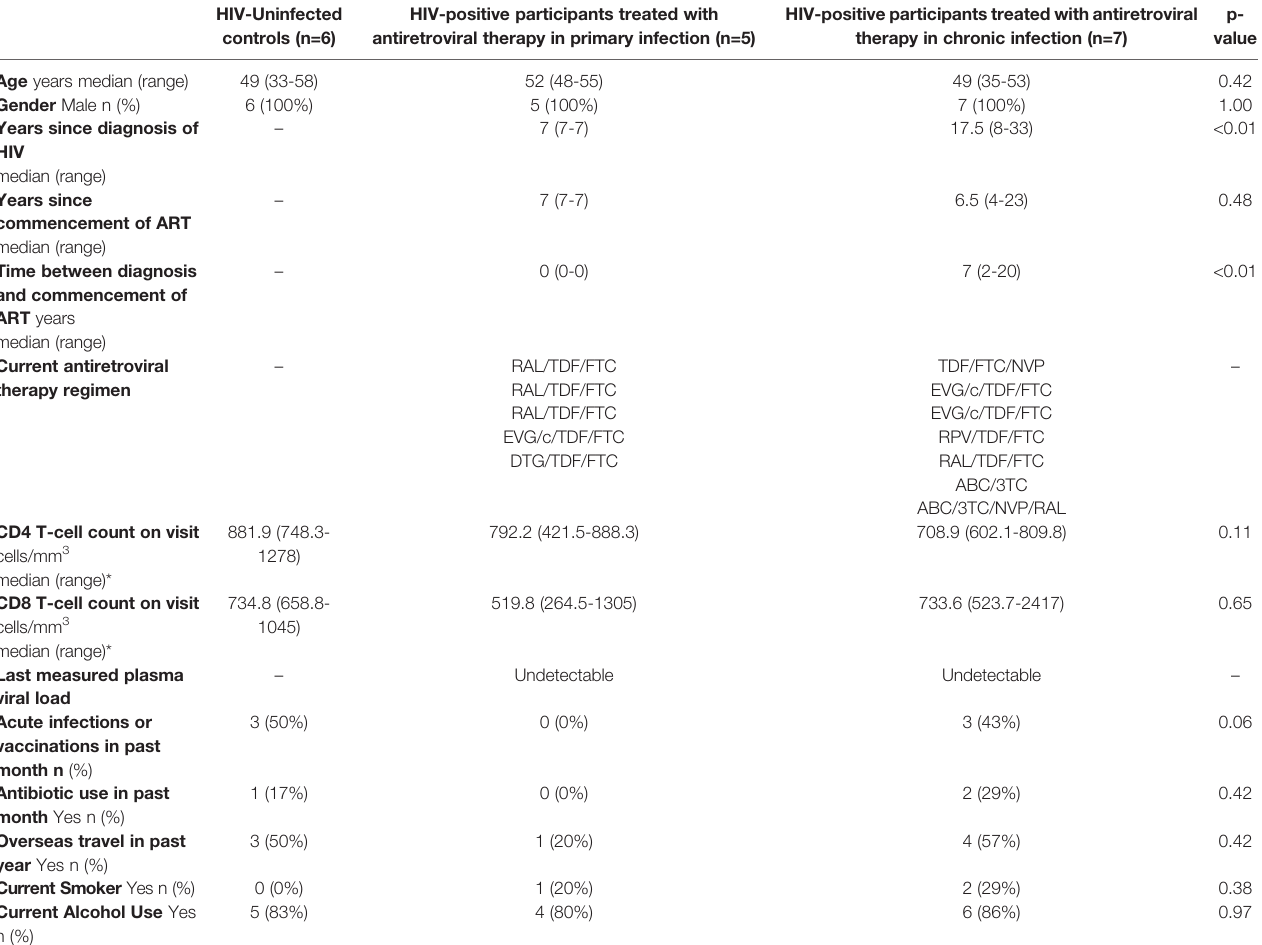
TABLE 1 | Baseline characteristics and clinical parameters of study